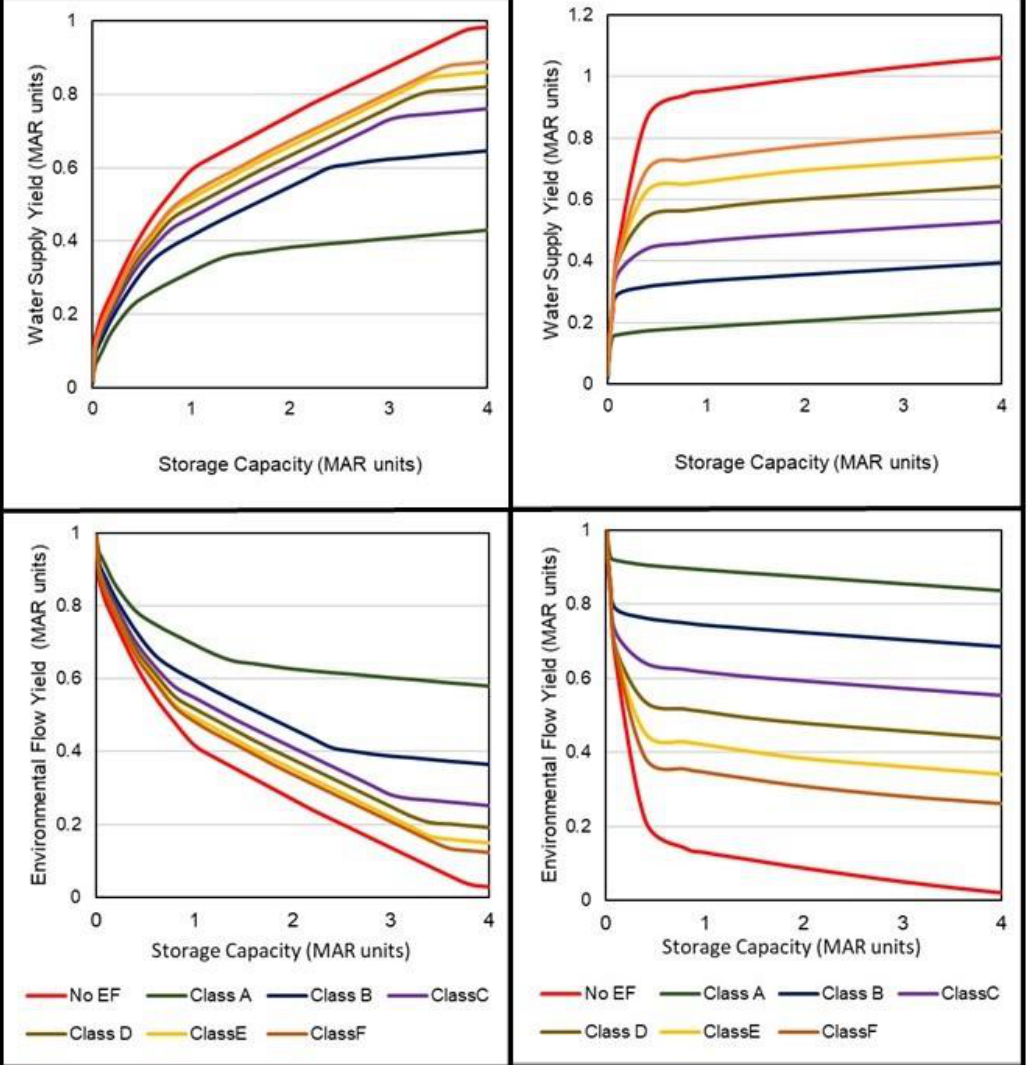
Figure 5. Behavior of Water Supply Yield ( top ) and Environmental Flow Yield ( bottom ) under different Environmental Management Classes (EMC) for a hypothetical reservoir through which all river runoff is routed for Malwatu Oya ( left ) and Kalu Ganga ( right ).